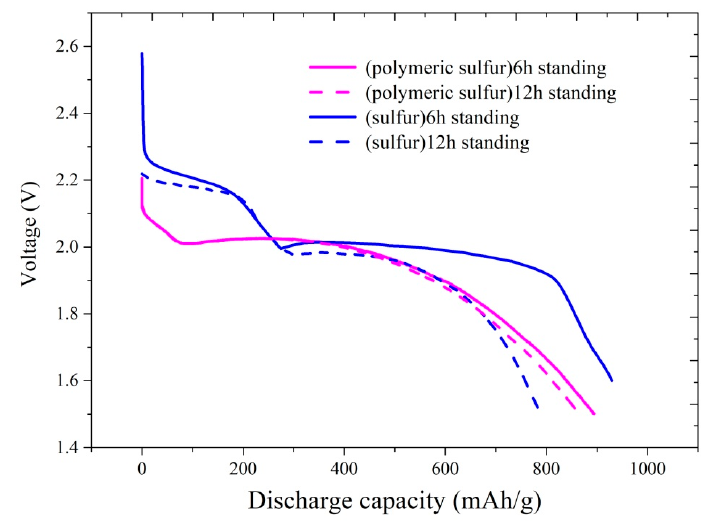
Figure 5. Discharge curves of the Li-S cells with commercial sulfur and the synthesized polymeric sulfur as a cathode after resting for 6 h and 12 h.